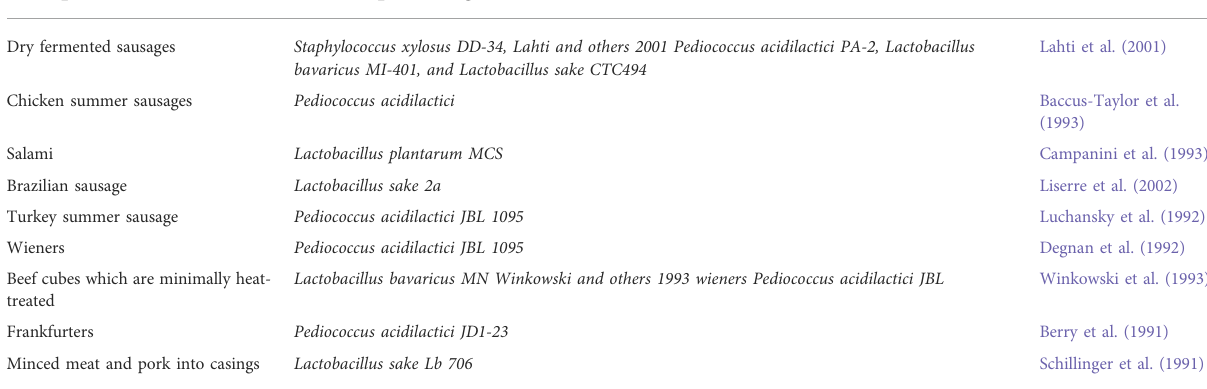
TABLE 3 Bacteriocins used in meat